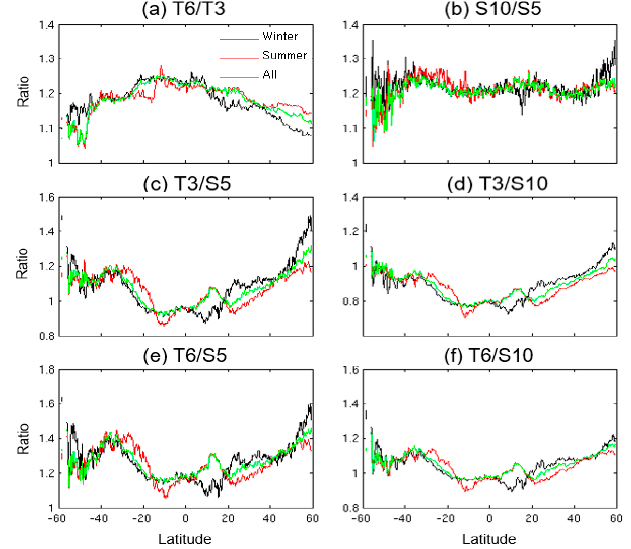
Figure 5. Zonal mean plots of the relative-error ratios shown separately over land.